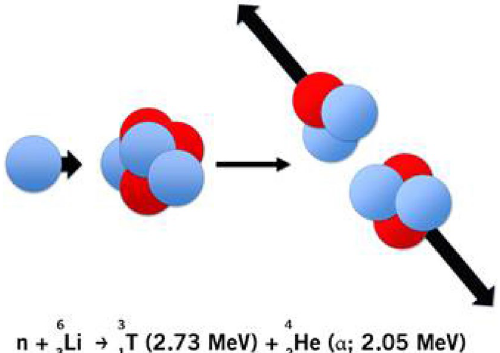
Figure 5. Schematic illustration of the 6 Li(n,α) 3